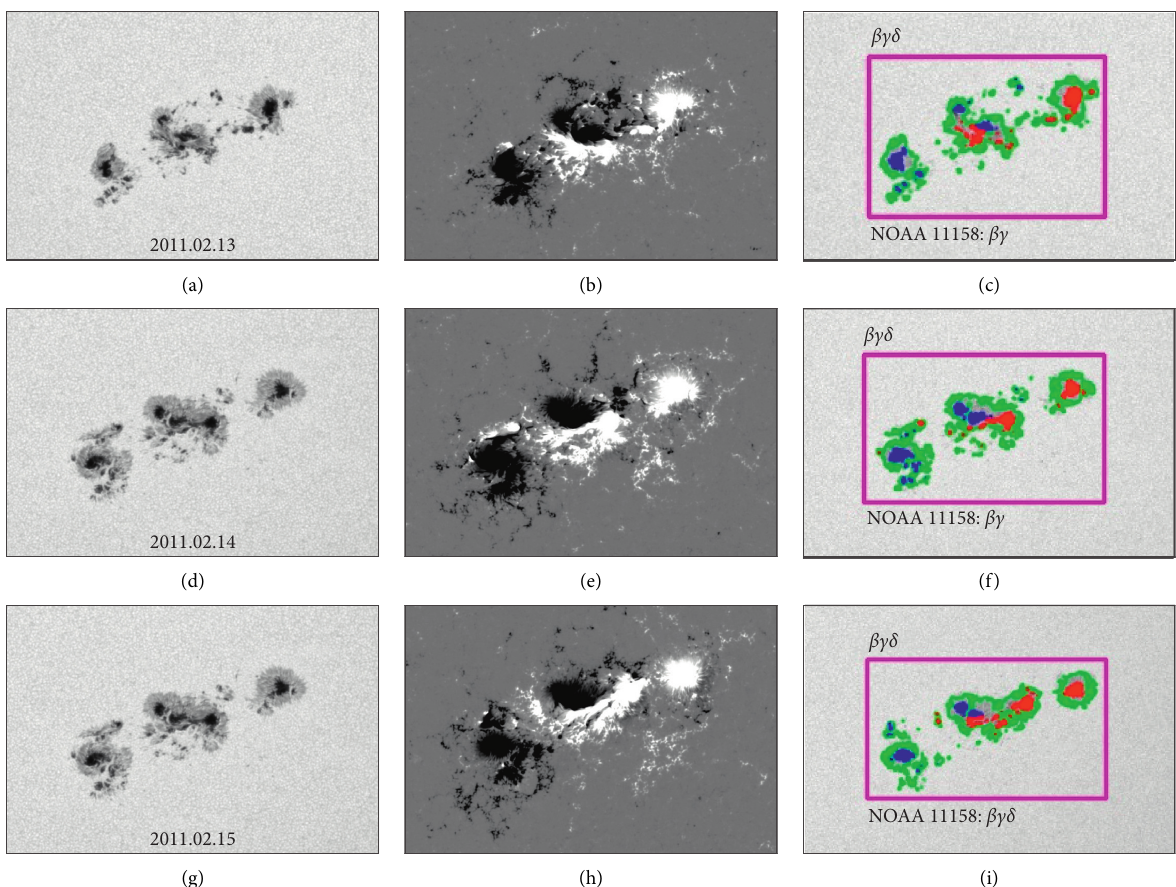
Figure 7: The classifications of NOAA 11158 given by our method and NOAA. The columns from left to right are the continuum image, magnetogram, and the classification result. The rows are the evolving procedure, which is on the 13th, 14th, and 15th of February 2011, respectively. All the times are 20:00:00 UT. The sunspot groups with solid-line boxes are detected by our method, where the classification results are displayed at the upper left of each box. The AR number and classification given by NOAA are manually labeled at the box